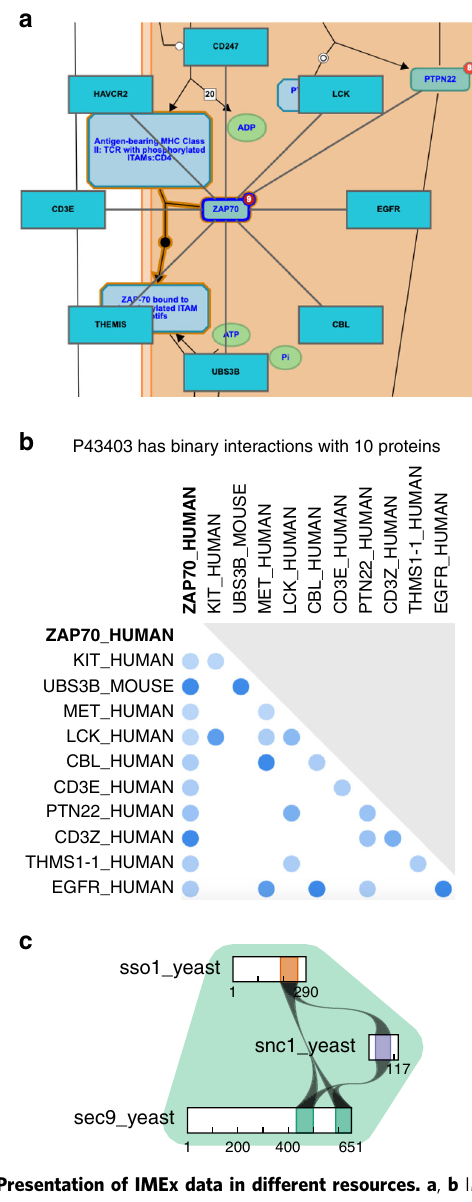
Fig. 4 Presentation of IMEx data in different resources. a , b IMEx data for the human ZAP70 protein (P43403) represented in a Reactome and b UniProt. c IMEx-derived binding domain data for the S. cerevisiae vesicular SNARE complex SSO1-SEC9-SNC1 (CPX-1365) used in the Complex